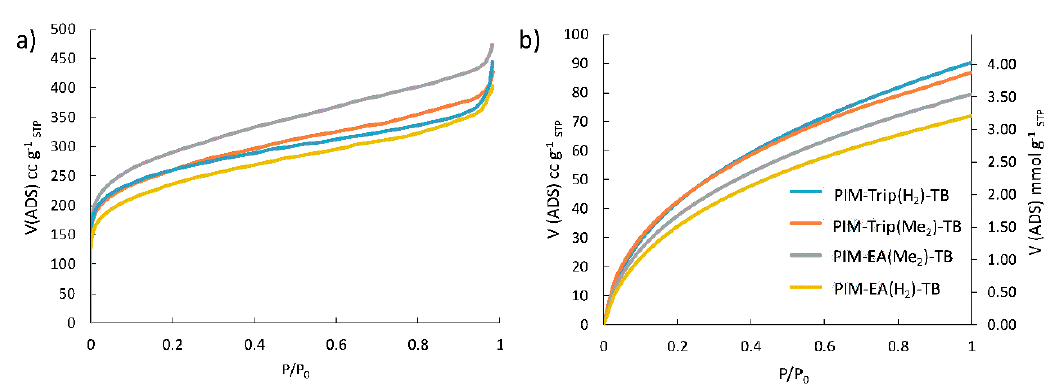
Figure 2. ( a ) N 2 adsorption isotherms measured at 77 K (desorption curves are not shown for clarity); ( b ) CO 2 uptake measured at 273 K.